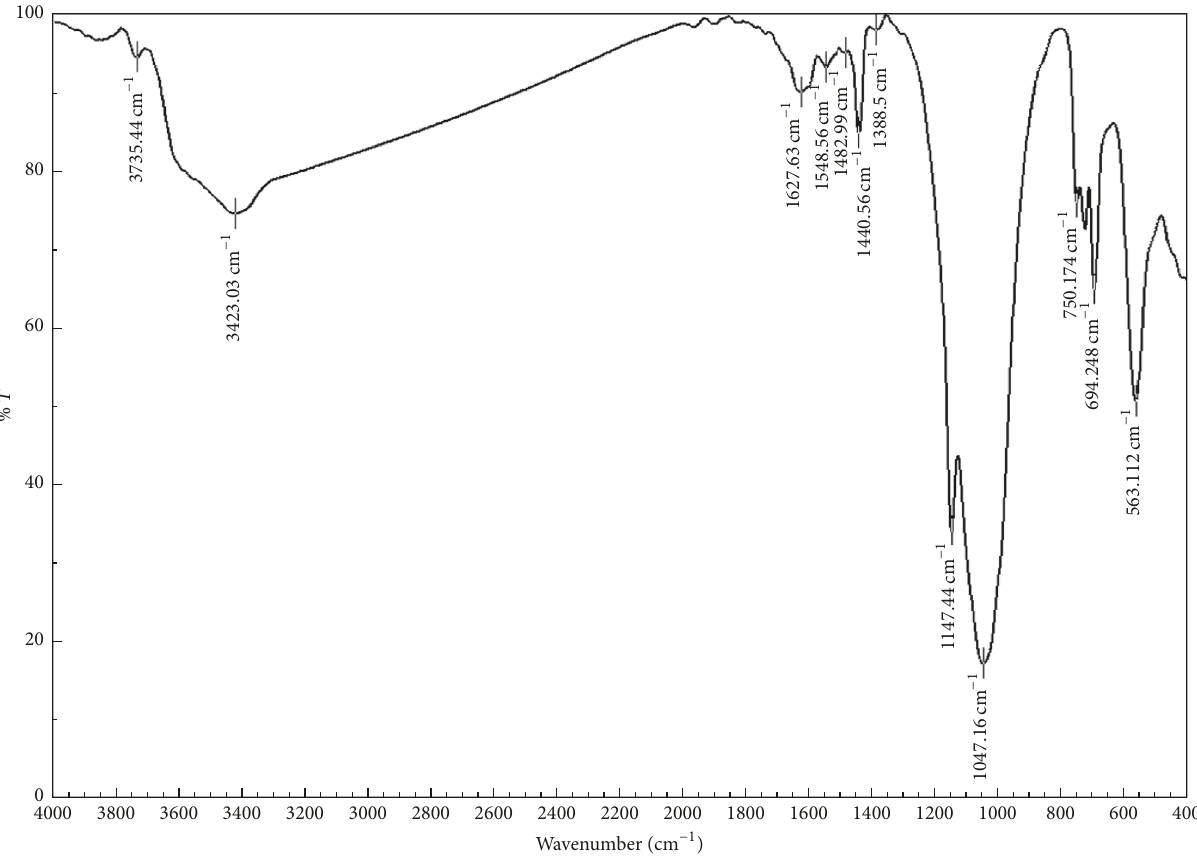
Figure 2: IR spectrum for compound S1 (PPA/Zr(OBu) 4 = 2/1).